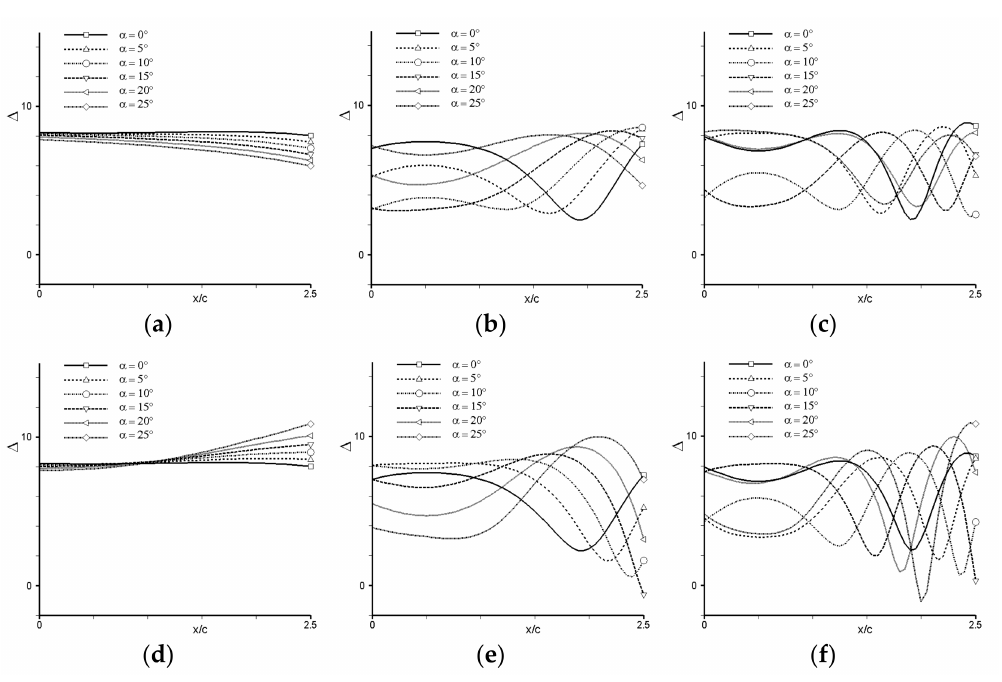
Figure 12. Low to high frequency ( St = 0.294, 1.47, 2.94) noise radiation from the trailing edge of an airfoil set at low to high incidences ( α = 0 ◦ , 5 ◦ , 10 ◦ , 15 ◦ , 20 ◦ , 25 ◦ ). From left to right: St = 0.294 ( a , d ), St = 1.47 ( b , e ), St = 2.94 ( c , f ). Deltas (in dB) between the incident and total RMS pressure fields,